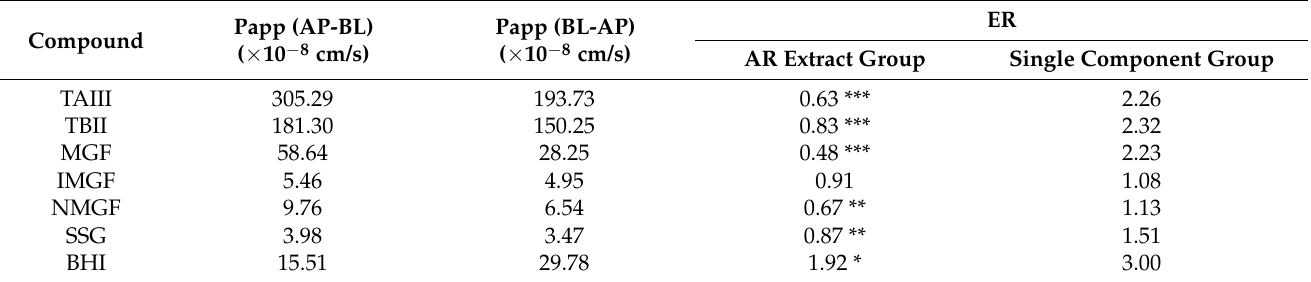
Table 2. The ER and Papp of seven components in AR extract (n = 3).